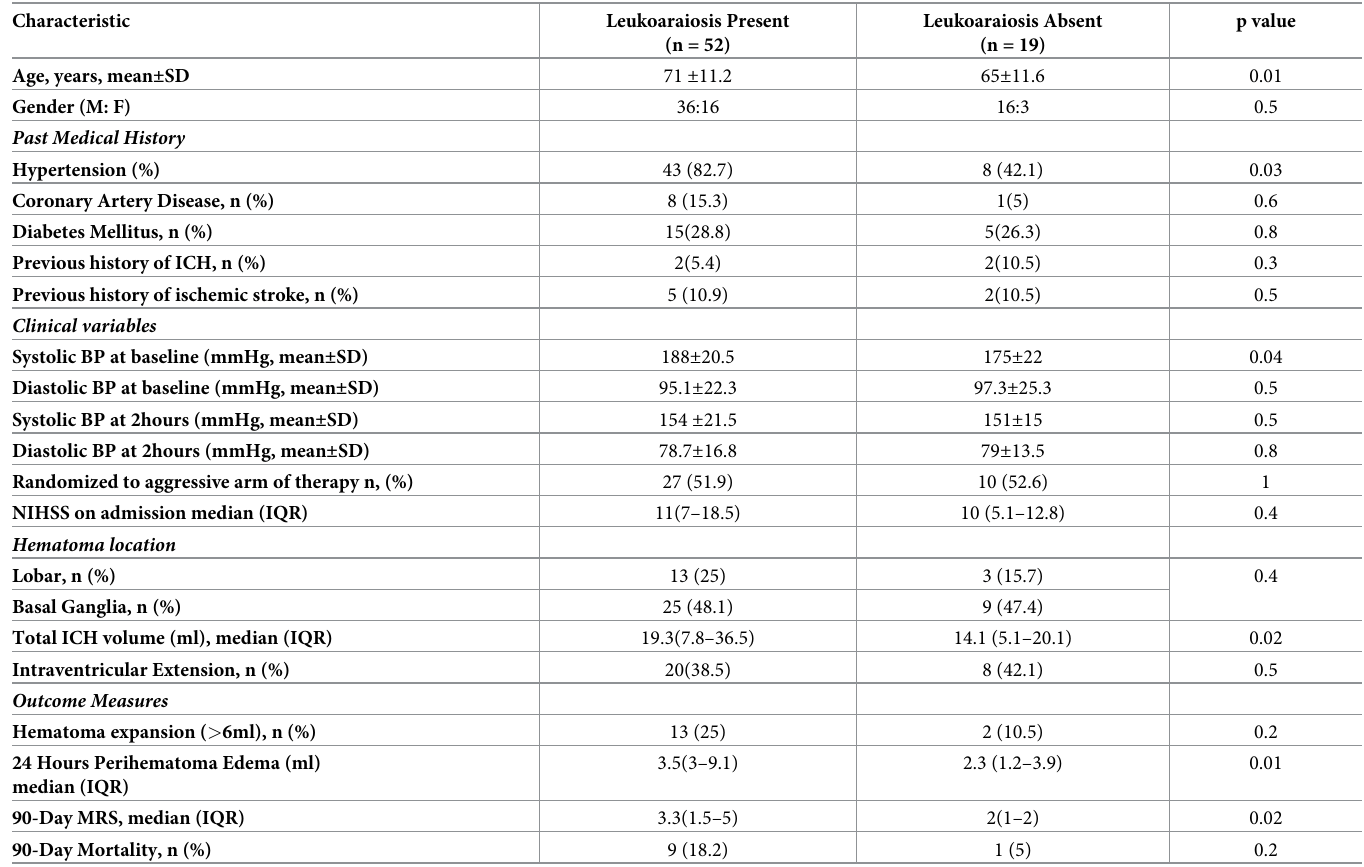
Table 1. Baseline characteristics of intracerebral hemorrhage patients with and without